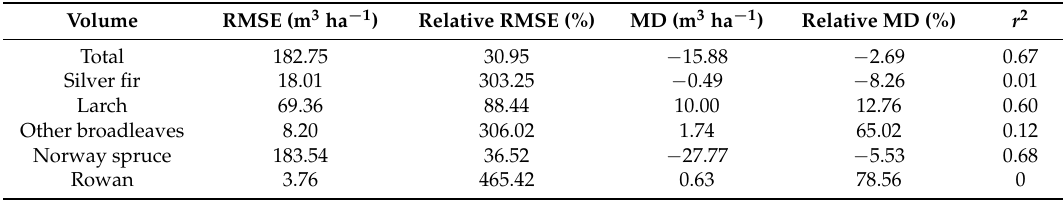
Figure 4. Observed versus predicted species-specific volumes at the plot level derived from the semi-ITC method. Table 6. Results of the predicted volumes using the k-nearest neighbor approach derived from ABA at the plot